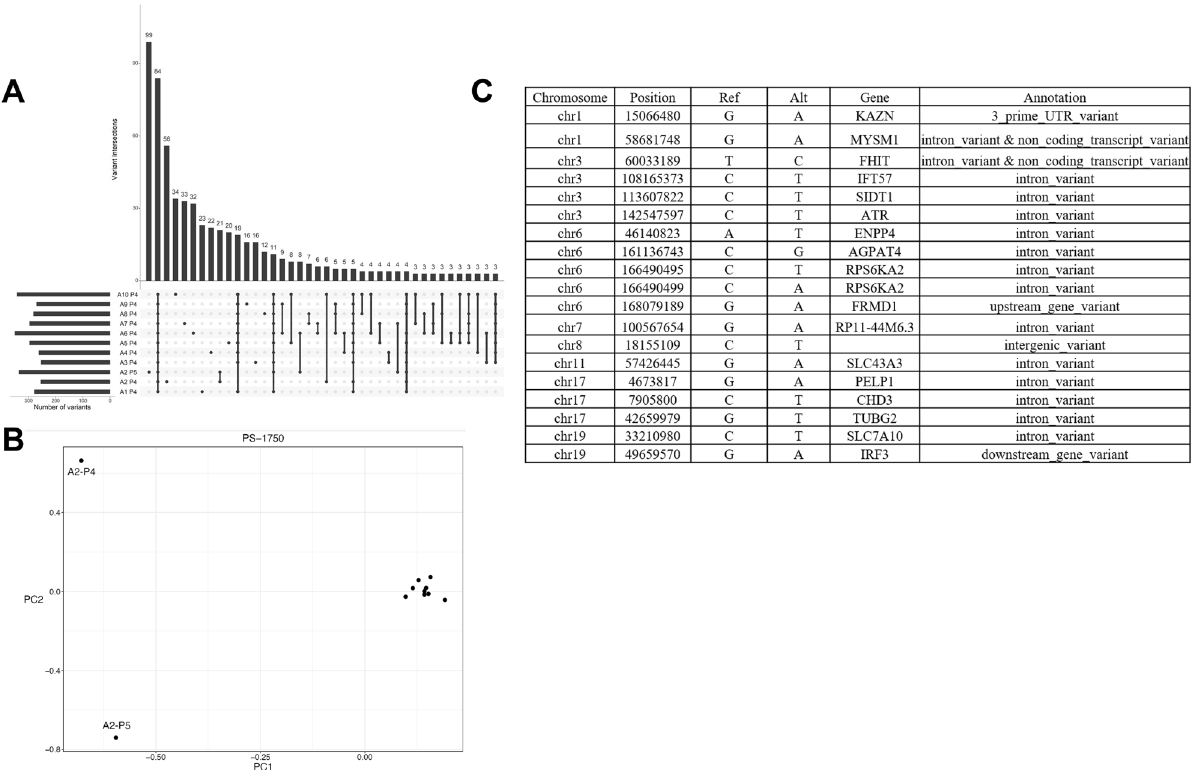
Figure 3. Shared and unique fixed variants in PS13-1750. ( A ) Upset plot displaying patterns of variant sharing among samples in flow sorted biopsies. ( B ) Principal component analysis (PCA) distinguishes